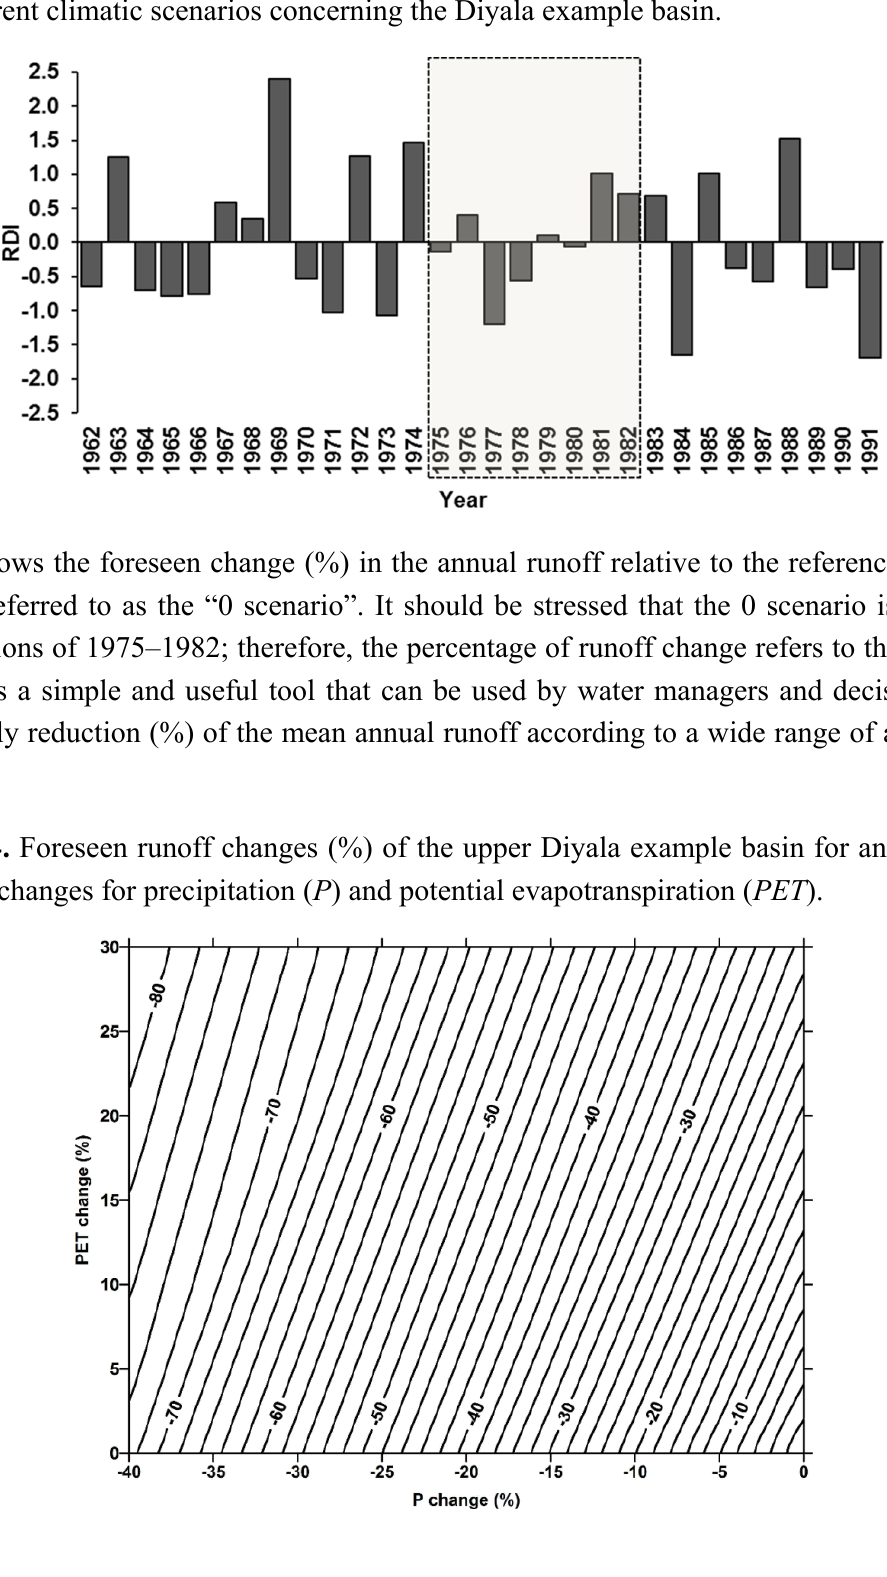
Figure 3. Selected simulation period for the Reconnaissance Drought Index ( RDI ) applied for different climatic scenarios concerning the Diyala example basin.